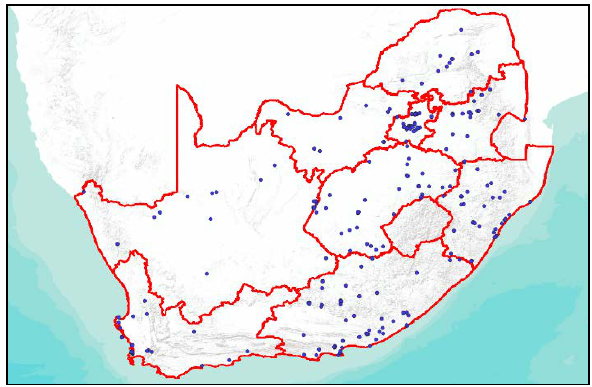
Figure 1: Map of known monuments and memorials in South Africa prior to the